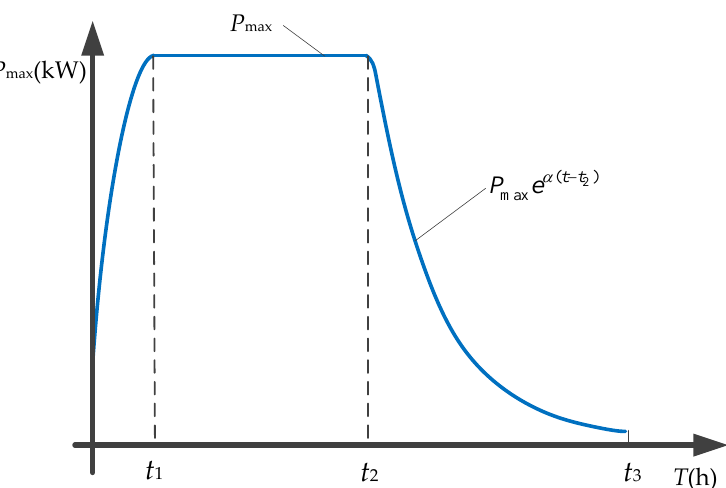
Figure 3. Maximum charging power of battery at different times.